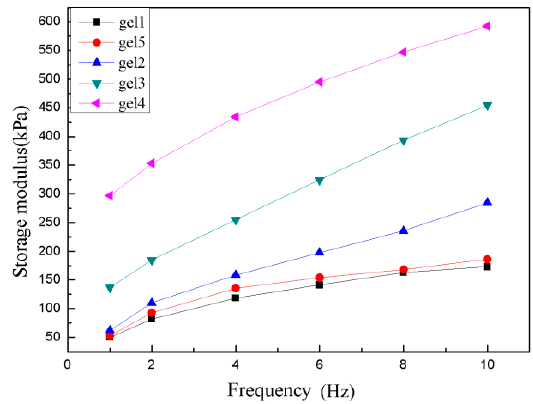
Figure 7. Variation curve of storage modulus with frequency of hydrogels .